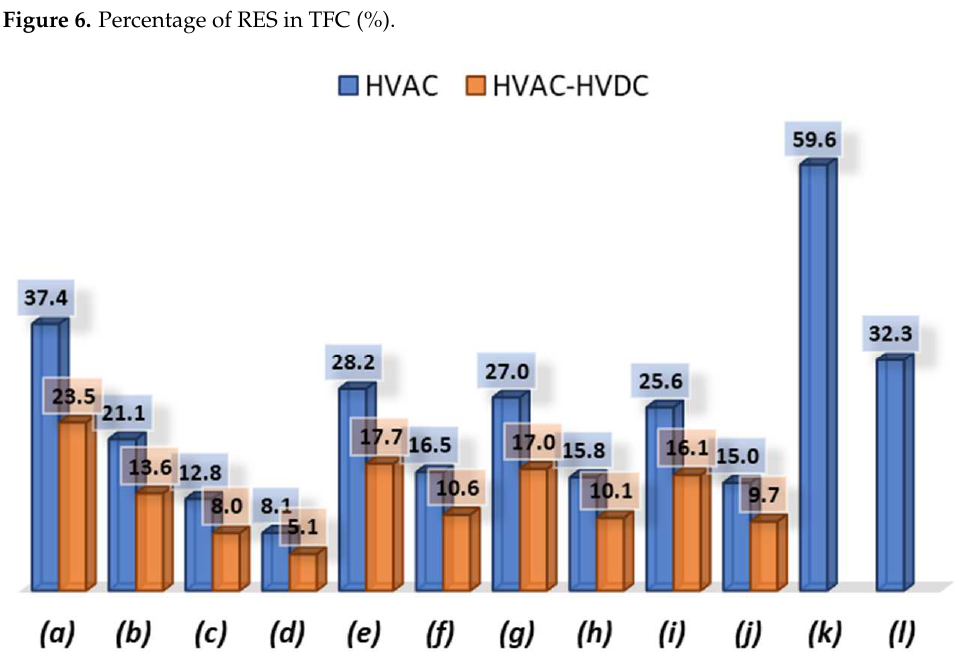
Figure 7. Carbon emission over GDP (tCO2/M EUR).